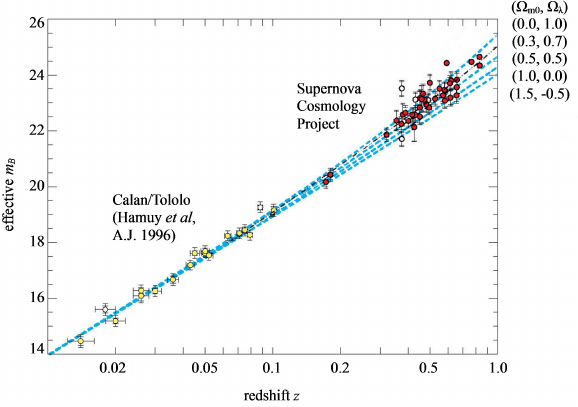
Figure 1. Horizontal: the redshift z, which is a measure for the veloc- ity of a supernova. Vertical: the magnitude m is a measure for the